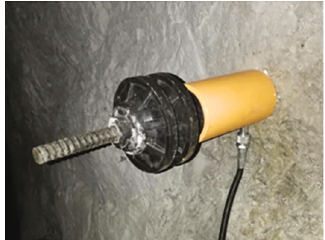
Figure 4: Site photo of the test location.